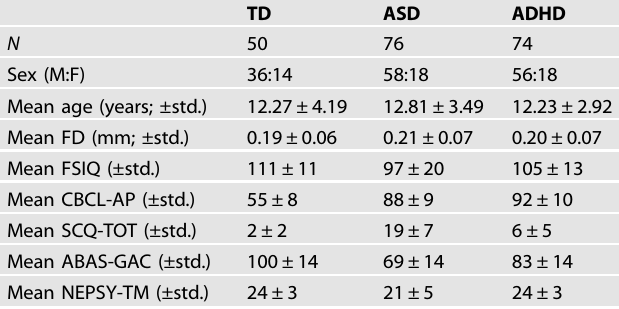
Table 1. Participant demographics and descriptive statistics for the clinical behavioural measures for the TD, ASD, and ADHD participants.